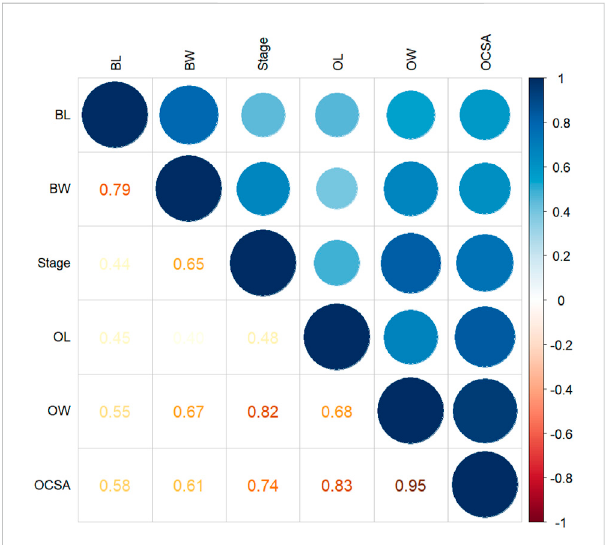
FIGURE 5 Correlation matrix of all variables. The larger the absolute value and the darker the color, the stronger the Pearson ’ s correlation (positive or negative). Circles in different colors represent signi fi cant correlation; p < 0.05. BL, body length; BW, body weight; OL, ovarian length; OW, ovarian width; OCSA, ovarian cross-sectional area.